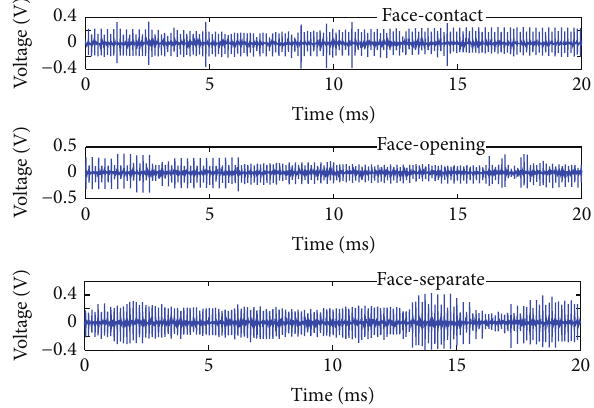
Figure 5: Variations of AE